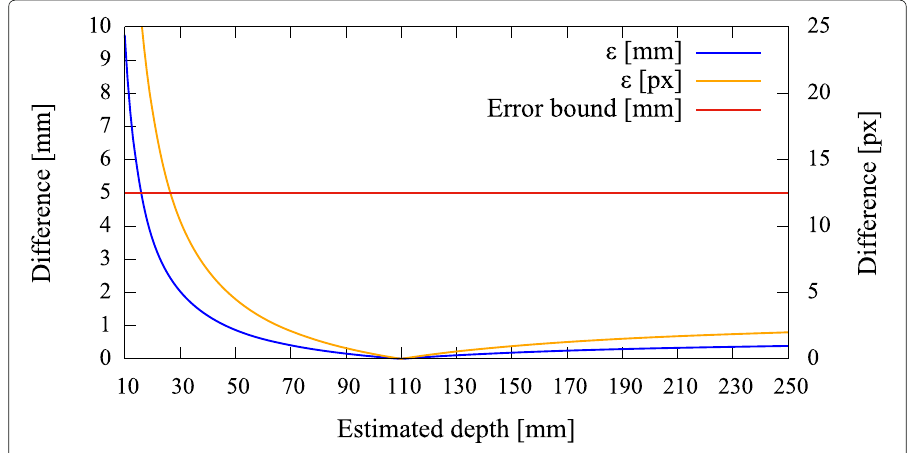
Fig. 7 Simulated disparities (cid:3) in millimeter and pixels for different estimated depths, given zero camera rotation and a translation of t = ( 0.5,0.5,3.0 ) T mm with respect to the pinhole. The camera is not allowed to move more thanks to constructive constraints. A minimal error is reached where our depth expectation of 110 mm matches the actual depth of the